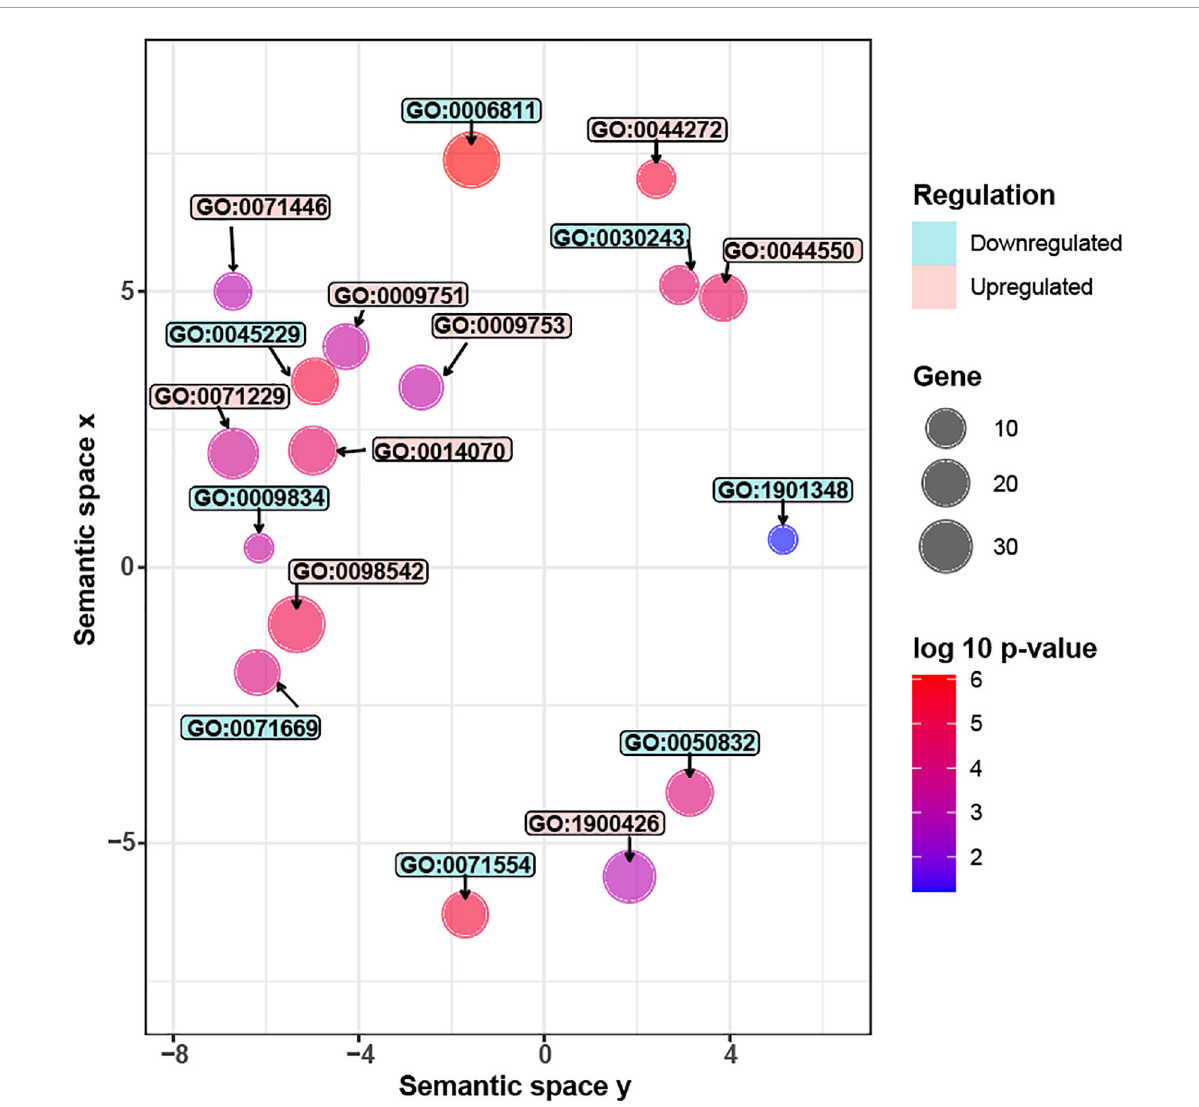
FIGURE4 Significantly enriched GO terms in G. inflata AtMYB12 -OX hairy roots. Gene Ontology (GO) analyses of differentially expressed genes (DEGs). Upregulated GO terms are colored in red while downregulated terms are in blue . Each circle represents one GO term. The circle size represents the number of genes in each GO category while the color represents the significance level. Description of the upregulated GO terms (from top to bottom): GO:0042742, defense response to bacterium; GO:0071446, cellular response to salicylic acid stimulus; GO:0044550, secondary metabolite biosynthetic process; GO:0009751, response to salicylic acid; GO:0009753, response to jasmonic acid; GO:0071229, cellular response to acid chemical; GO:0014070, response to organic cyclic compound; GO:0098542, defense response to other organism; GO:1900426, positive regulation of defense response to bacterium. Description of the downregulated GO terms (from top to bottom): GO:0006811, ion transport; GO:0030243, cellulose metabolic process; GO:0045229, external encapsulating structure organization; GO:0009834, plant-type secondary cell wall biogenesis; GO:1901348, positive regulation of secondary cell wall biogenesis; GO:0071669, plant-type cell wall organization or biogenesis; GO:0050832, defense response to fungus; GO:0071554, cell wall organization or